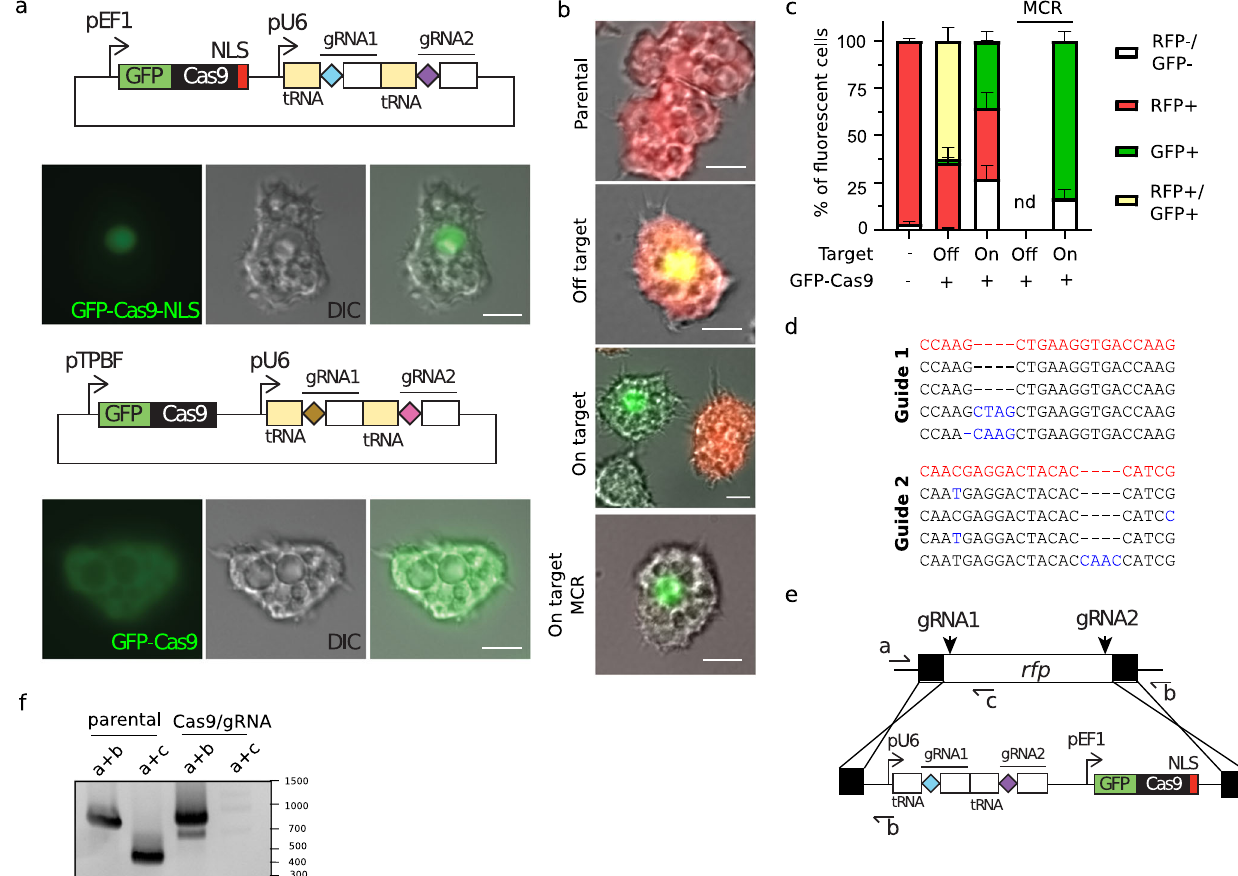
Fig. 1 | CRISPR/Cas9 allows manipulation of A. castellanii . a Constructs used to constitutively express Cas9 in A. castellanii . The sequence of the gRNA is depicted with diamonds followed by the Cas9-binding scaffold and an A. castellanii tRNA (yellow rectangles). The localization of the GFP-Cas9 fusion for the different con- structsisshownby fl uorescence.Micrographsarerepresentative of3independent experiments. Scale bar: 10 μ m. b Representative micrographs showing amoebas expressing mRFP (vector Vc241) and GFP-Cas9 after selection for 2 – 3 weeks with the appropriate drug(s) (refer to materials and methods). mRFP (product of the targetedgene)andGFP(IndicatingCas9expression) fl uorescenceareshown.MCR: mutagenic chain reaction. Scale bar: 10 μ m. c The quanti fi cation ofthe micrograph shown in ( b ). The mean±SD of at least 200 amoebas (3 independent experiments ( n =3)) is shown. Amoebas were classi fi ed either as non- fl uorescent, mRFP+, GFP+ or GFP+mRFP+. MCR: mutagenic chain reaction. Guides targeting pandoravirus